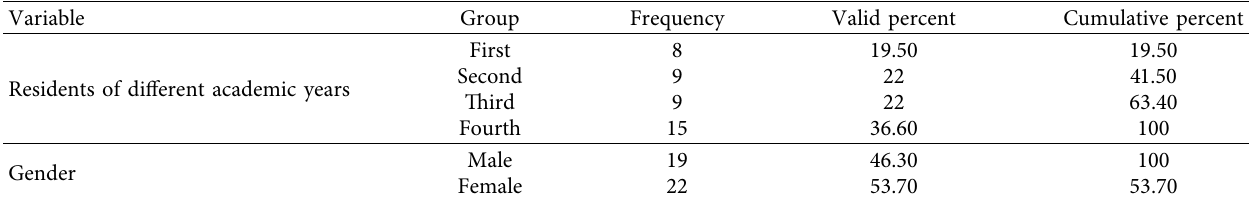
Table 1: Demographic distribution of the sample by gender and residents of different academic years.